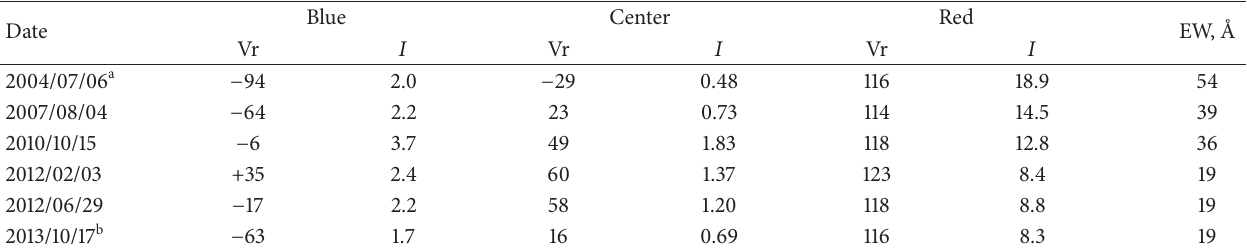
Table 2: Parameters of the 𝐻𝛼 line in the spectrum of MWC 930 in 2004–2013.